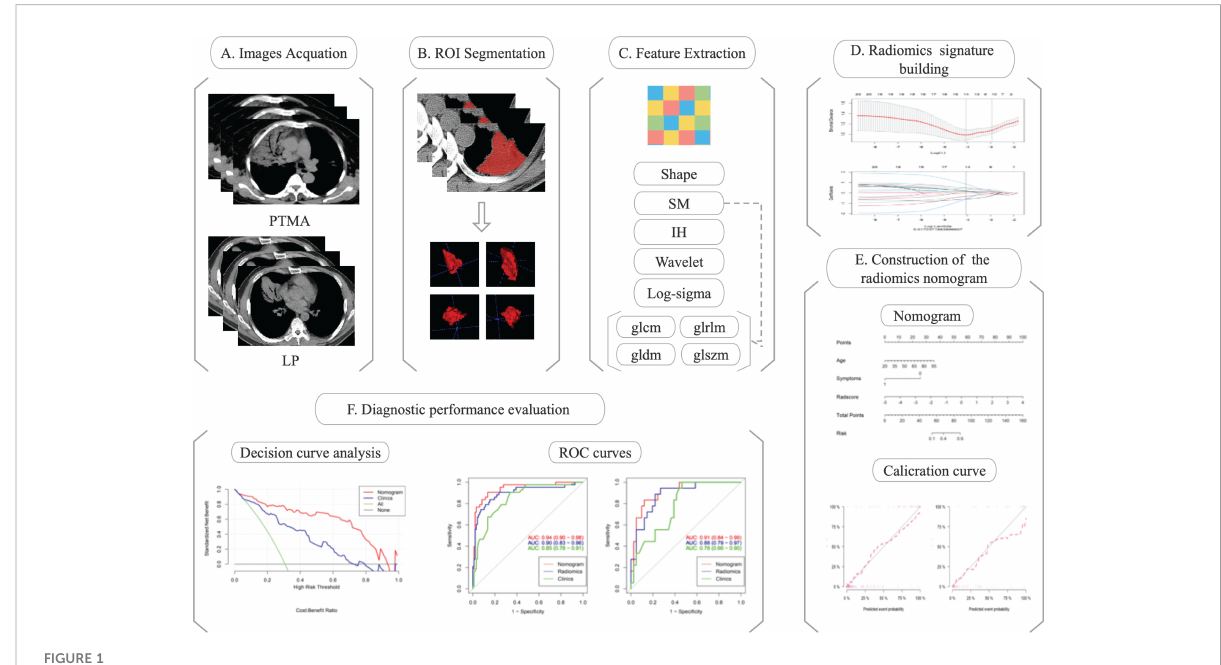
FIGURE 1 The fl ow diagram of this